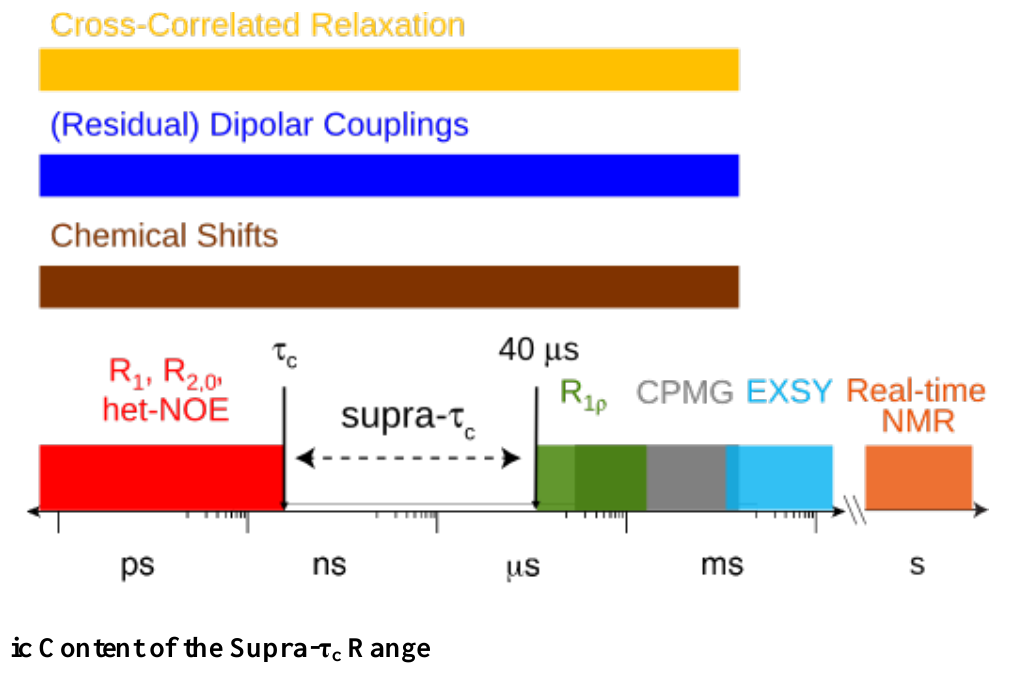
Figure 1. The accessible time-scale for NMR observables and the respective limits for some NMR